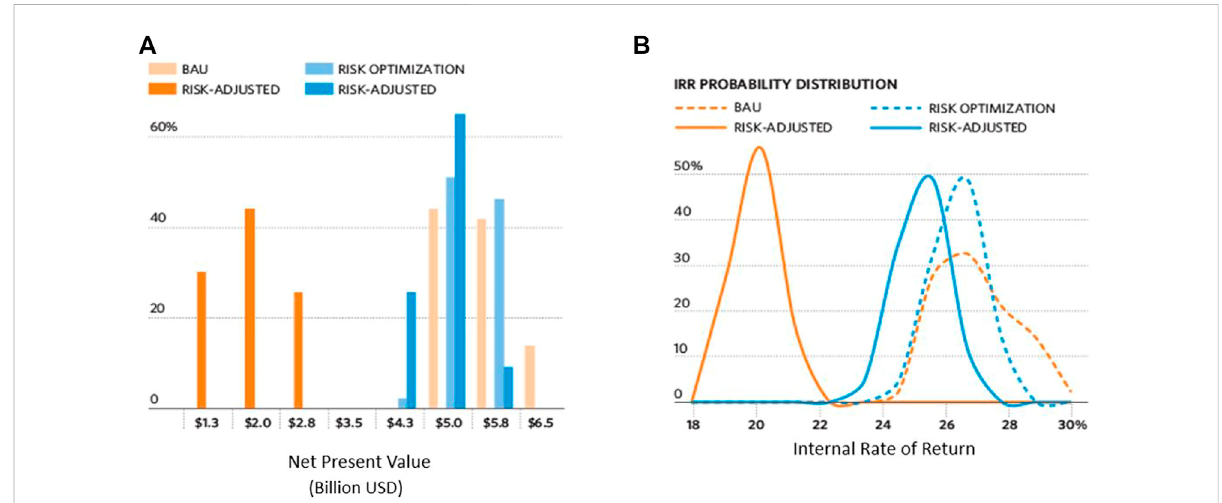
FIGURE 9 DistributionofNetPresentValue(NPV) (A) andInternalRateofReturn(IRR) (B) forBAUcomparedtoriskoptimizationscenariosforhydropower development in the Magdalena Basin, Colombia. Both fi gures show values of the aggregated cash fl ows from all projects in a scenario, with distributions of values re fl ecting 50 simulations of cash fl ows for each scenario.